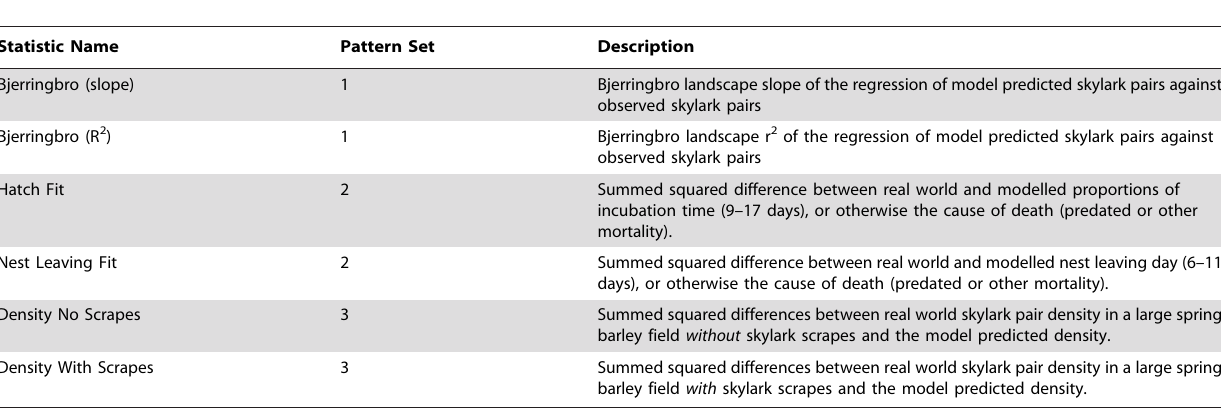
Table 1. Overview of the fit statistics used to determine the fit to the observed real world pattern data.